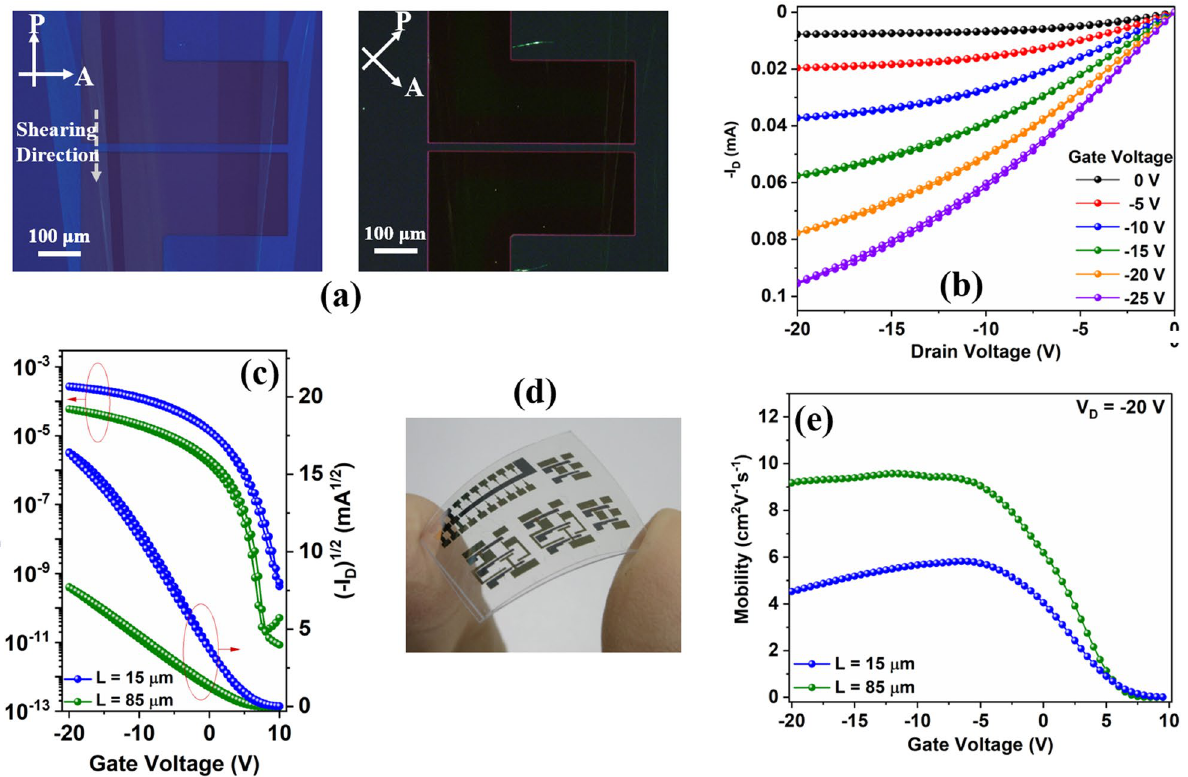
Figure 4. ( a ) Polarized optical microscopy (POM) images of the 4H–21DNTT crystalline film deposited on channel region defined by Au bottom contacts on Parylene C/flexible (PEN) substrate. ( b ) Output characteristics 4H–21DNTT OTFT at different gate bias voltage. ( c ) Transfer characteristics of the 4H–21DNTT OTFT devices (W/L = 450 μm/85 μm and 15 μm) on Parylene C/ flexible (PEN) substrate in the saturation region (V D = − 20 V) μ sat (L = 85 μm) = 9.40 cm 2 V −1 s −1 and μ sat (L = 15 μm) = 6.33 cm 2 V −1 s −1 . ( d ) Photograph of OTFT fabricated on flexible PEN substrate. ( e ) Saturation mobility (L = 85 μm and 15 μm) vs gate voltage plot for 4H–21DNTT OTFT prepared by shearing on Parylene C/flexible (PEN)